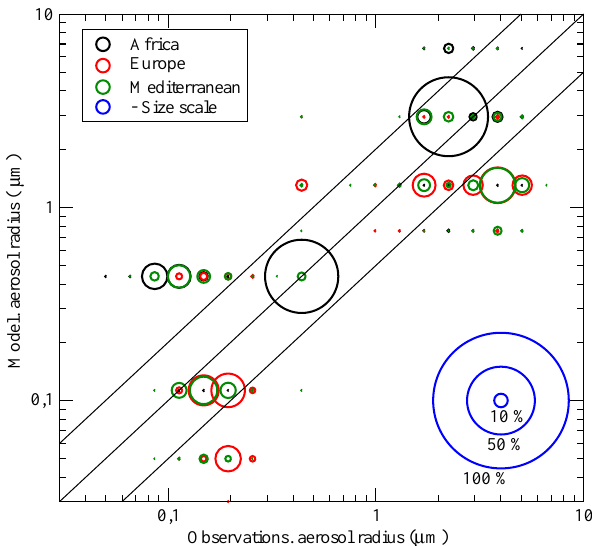
10 Observations. aerosol radius ( μ Figure 11. Scatter plot of the radius found in observations and model for the fine and coarse modes. The width of each symbol rep- resents the occurrence for each obs/model value (normalized with the highest value for each mode “fine” and “coarse” at each loca- tion). The blue circles represent the scale for the results, with exam- ples for sizes representing 10, 50 and 100%.